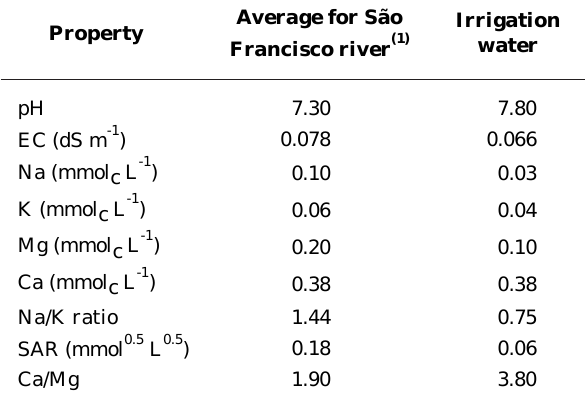
(Table 4): the points with concave plan curvature were wetter than points with convex curvature.